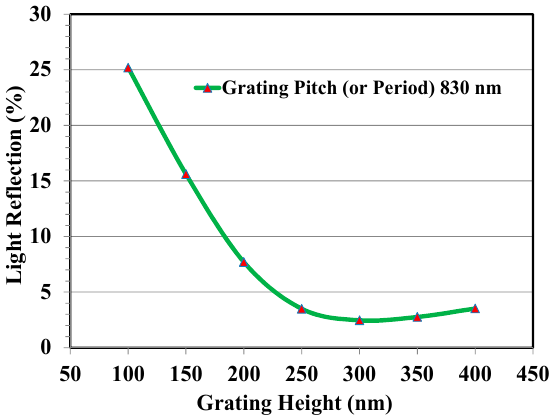
Figure 8. Light reflection versus nao ‐ grating height characteristics when the grating pitch or period is kept constant at 830 nm.